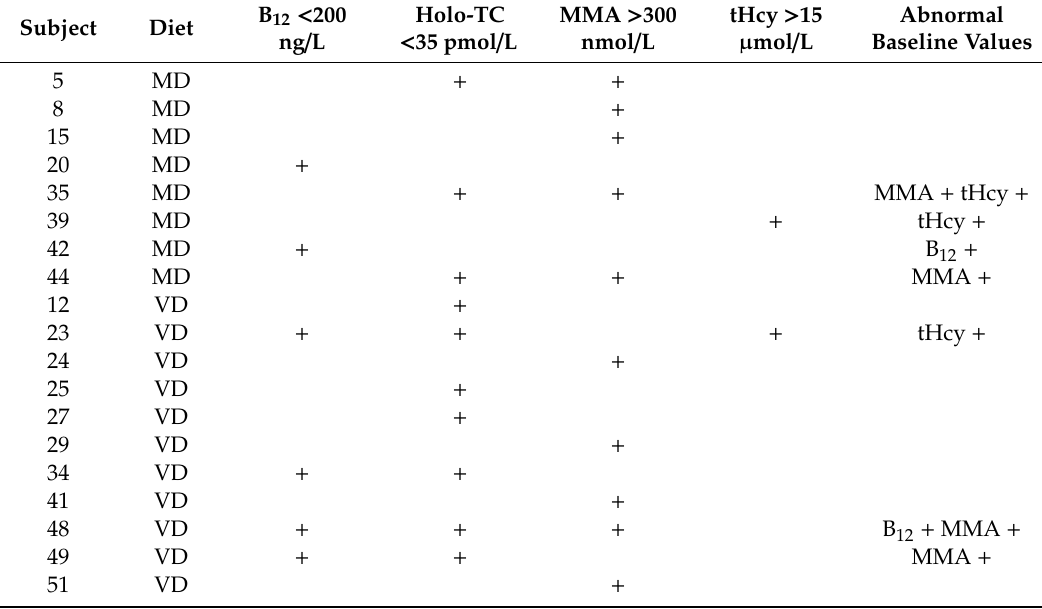
Table 4. List of subjects with abnormal serum parameters of vitamin B 12 metabolism at the end of the trial and comparison to baseline values ( n = 19). ( + shows abnormal value; holo-TC = holotranscobalamin, tHcy = Homocysteine, MD = meat-rich diet, MMA = Methylmalonic acid, VD = vegan